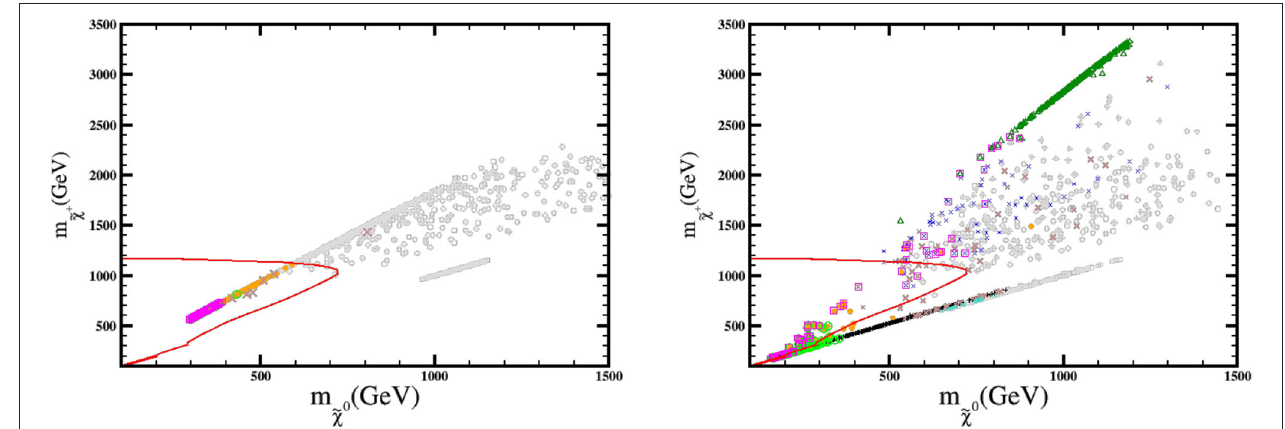
FIGURE 3 | Chargino masses vs. m χ 0 for the different models of SO(10) (left) and 4-2-2 (right). The points that can be compared with the LHC bounds follow the ˜ annotation of Figure 1 , while the ones excluded are inside a purple square. Gray points correspond to models that cannot be decomposed to SMS LHC signals (circles for A-resonances, squares for higgsino DM and diamonds for stop coannihilations). The red line corresponds to the largest masses that LHC can probe, according to the CMS and ATLAS public analysis.